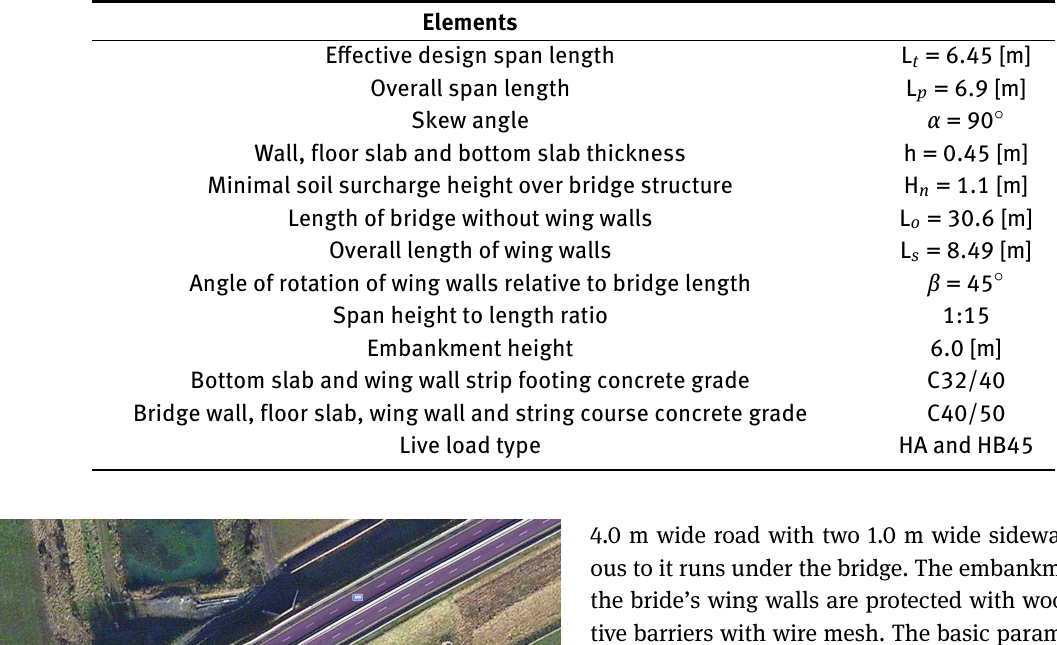
Table 1: Basic bridge parameters